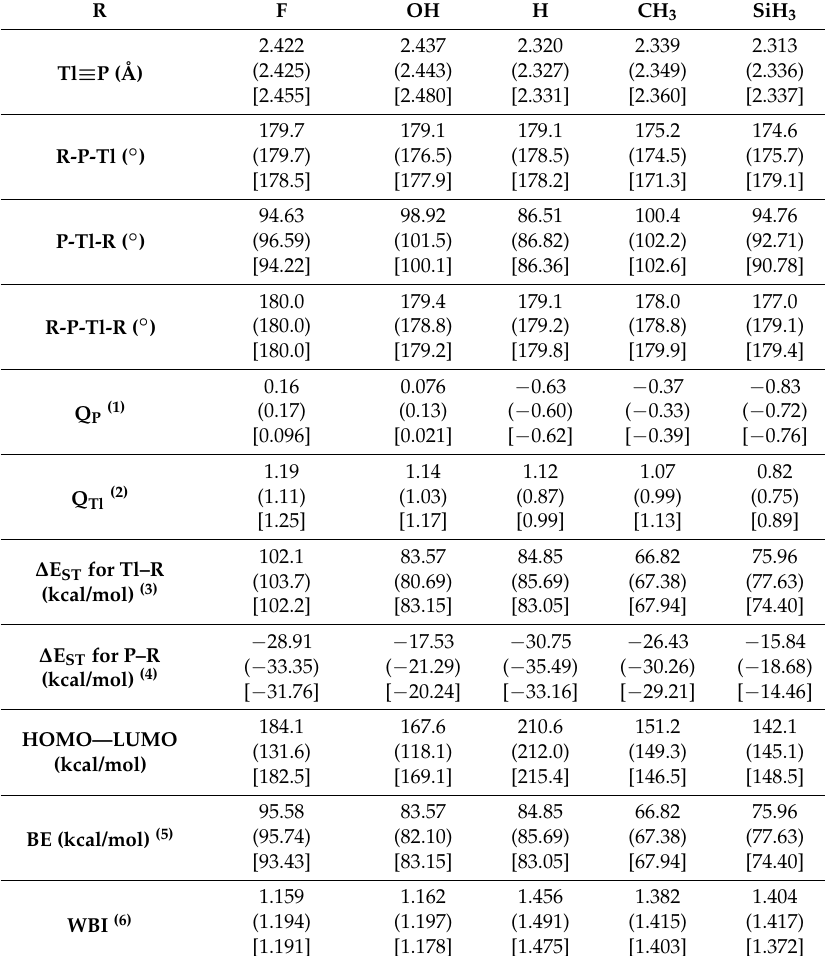
Table 1. The important geometrical parameters, the natural charge densities (Q Tl and QP), the binding energies (BE), the HOMO-LUMO energy gaps and the Wiberg Bond Index (WBI) for RTl ≡ PR using the M06-2X/Def2-TZVP, B3PW91/Def2-TZVP (in round brackets) and B3LYP/LANL2DZ+dp (in square brackets) levels of